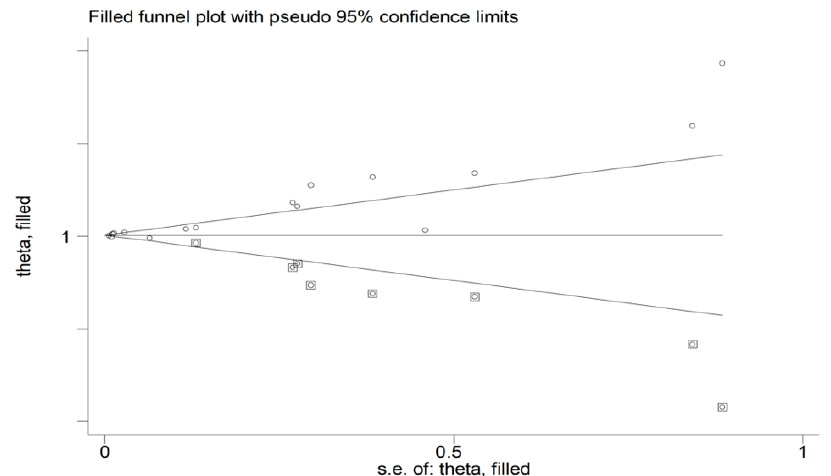
Figure 4. Funnel plot of studies investigating the association between the neutrophil-to-lymphocyte ratio and adverse outcomes after trimming and filling. Dummy studies and genuine studies are represented by enclosed circles and free circles, respectively.